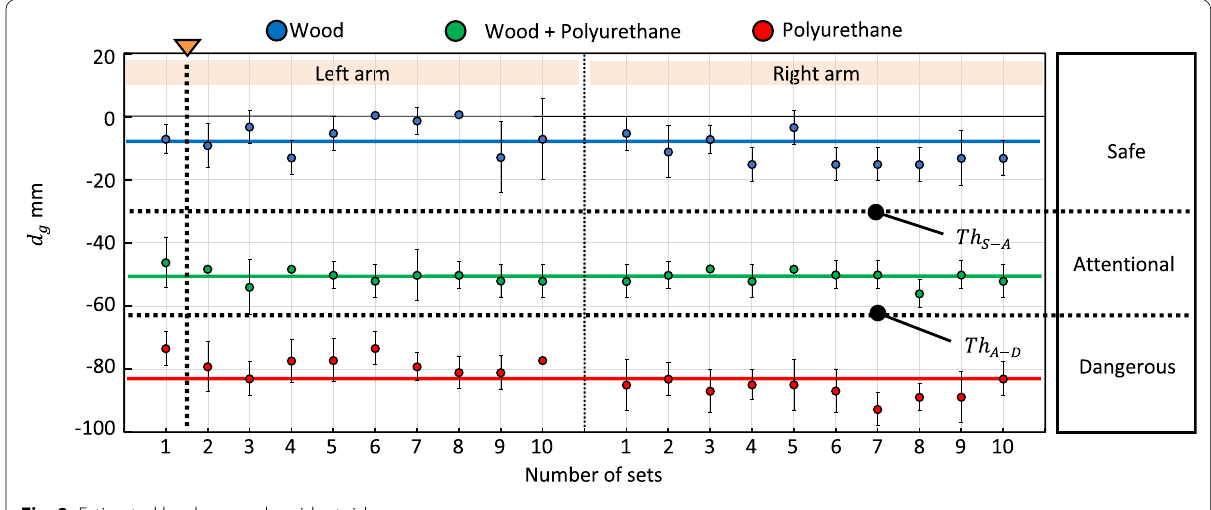
Fig. 9 Estimated hardness and accident